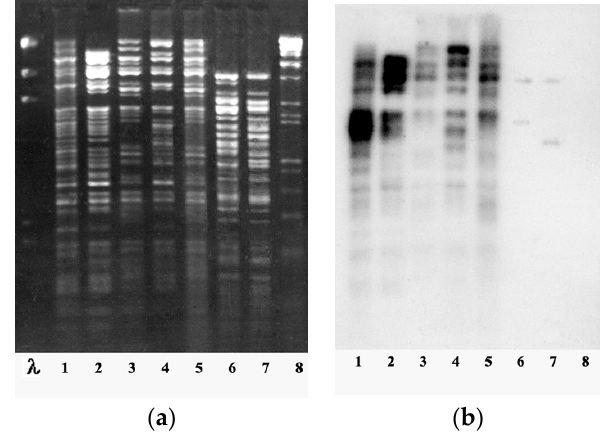
Figure 4. Examples of restriction analysis and DNA hybridization of phiKZ-like phages: ( a ) DNA restriction patterns obtained with Hin dIII for bacteriophages: ( λ ) lambda, (1) phiKZ, (2) phiLBG20, (3) phiLBG21, (4) phiLBG23, (5) phiLBG26, (6) phiLBG22, (7) phiLin68, and (8) phiRu. ( b ) Southern blot hybridization of 32P-labeled phiKZ DNA with Hin dIII DNA fragments of phages (1) phiKZ, (2) phiLBG20, (3) phiLBG21, (4) phiLBG23, (5) phiLBG26, (6) phiLBG22, (7) phiLin68, and (8) phiRu [62].